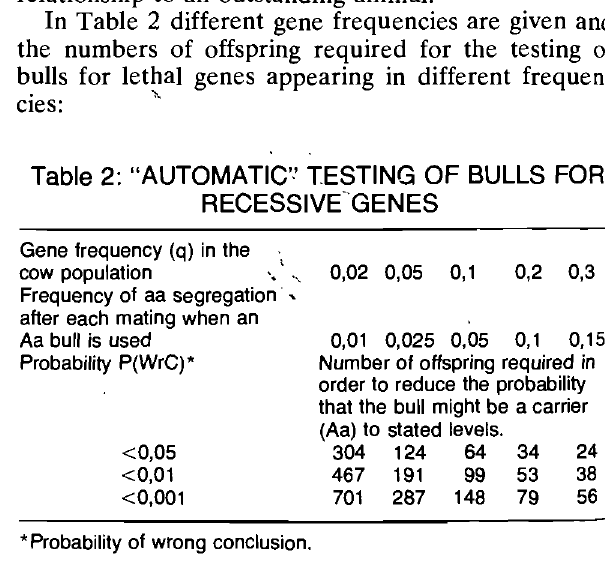
Table 1: THE MINIMUM NUMBER OF PROGENY REQUIRED TO TEST A MALE AT THE 5% LEVEL OF SIGNIFICANCE FOR HETEROZYGOSITY FOR A SINGLE AUTOSOMAL RECESSIVE GENE Test Mating